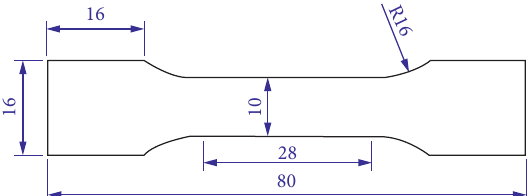
Figure 3: Dimensions of tensile samples along the skin (in mm).